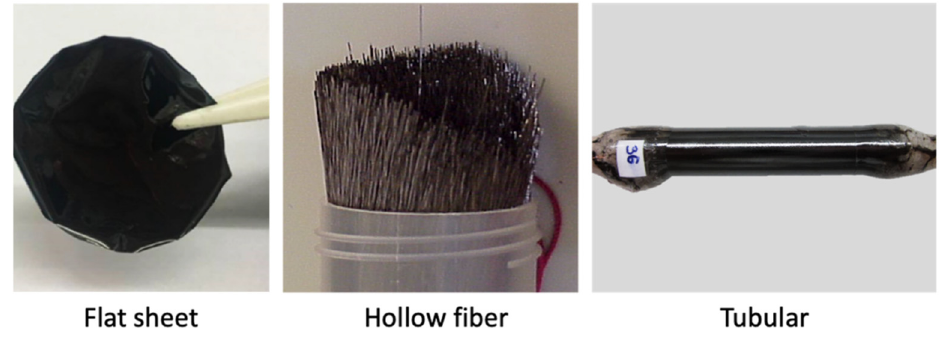
Figure 5. Di ff erent geometries of CMSM (adapted with permission from [30]). Figure 5. Different geometries of CMSM (adapted with permission from [30]). Figure 5. Different geometries of CMSM (adapted with permission from [30]).